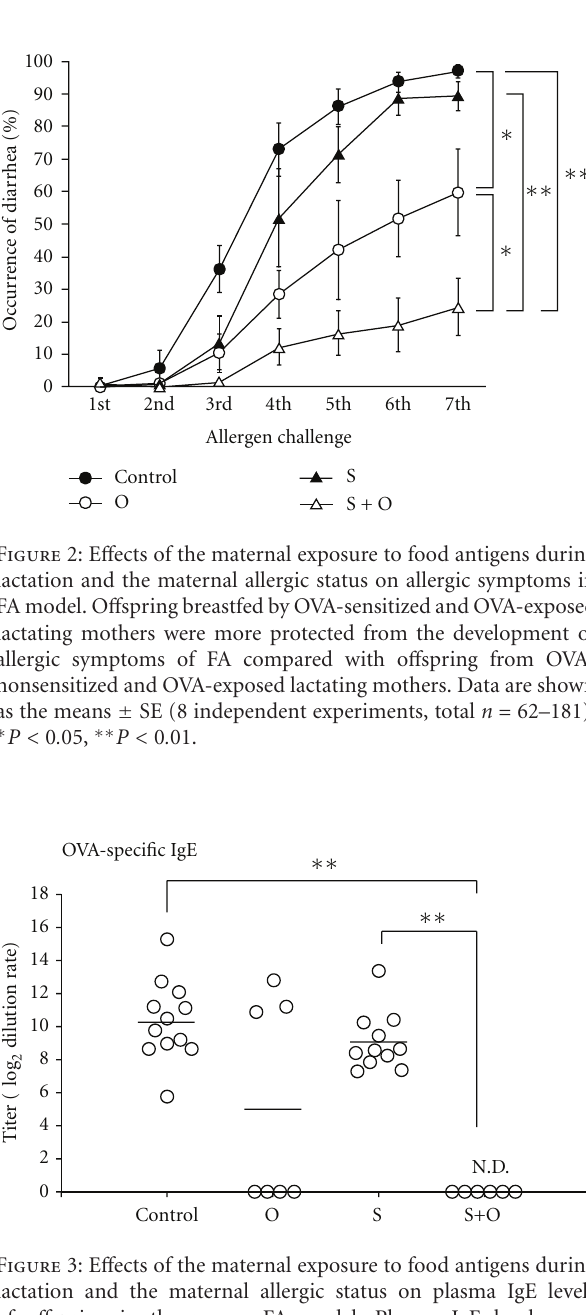
2.7. Data Analyses. The data are expressed as the means ± S.E. or the means and dot plots. Statistical comparisons